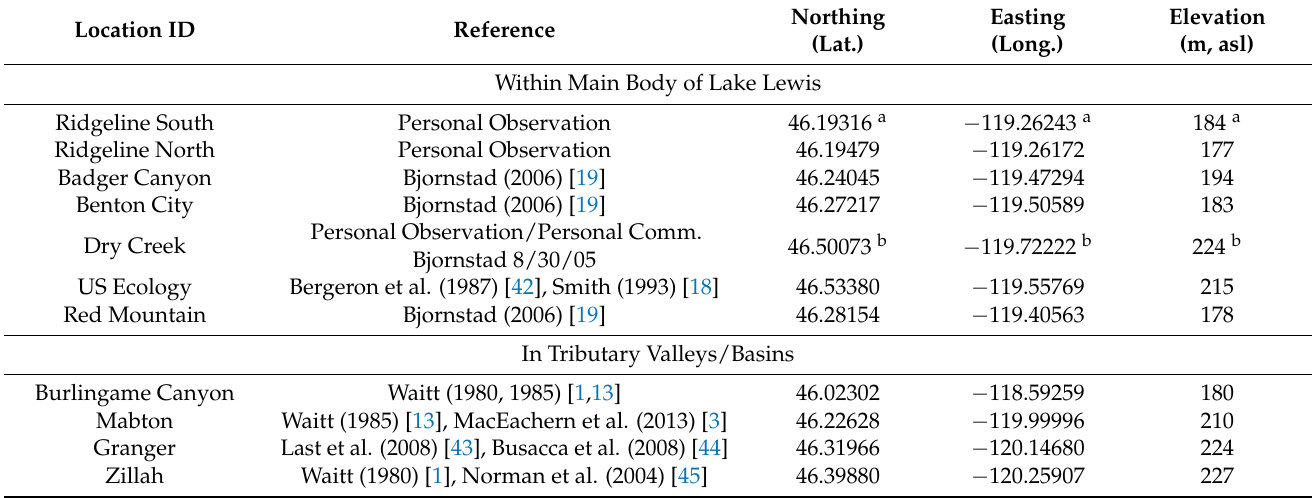
Figure 10. Exposure of at least 10 rhythmites at the Ridgeline South quarry, 8 of them overlying the MSH-S tephra. This site is ~140 m lower than CCMS, which lacks the MSH-S tephra. Elevation at the base of the Jacob staff was measured using a handheld global positioning system (GPS) as 179 m asl. Table 5. Approximate elevation at the top of selected rhythmite sections containing MSH-S. Elevations were estimated using Google Earth Pro unless otherwise